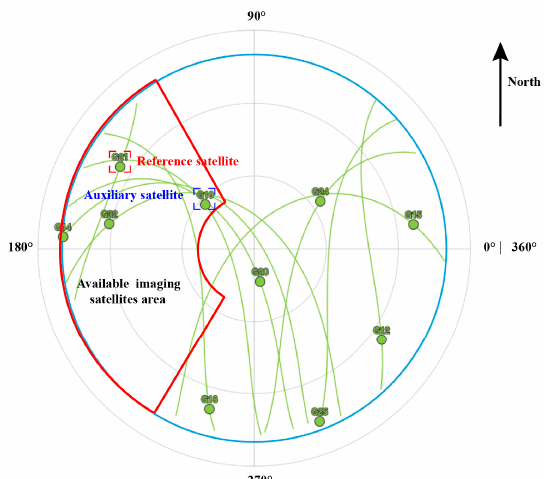
Figure 11. Sky map at 18:00.